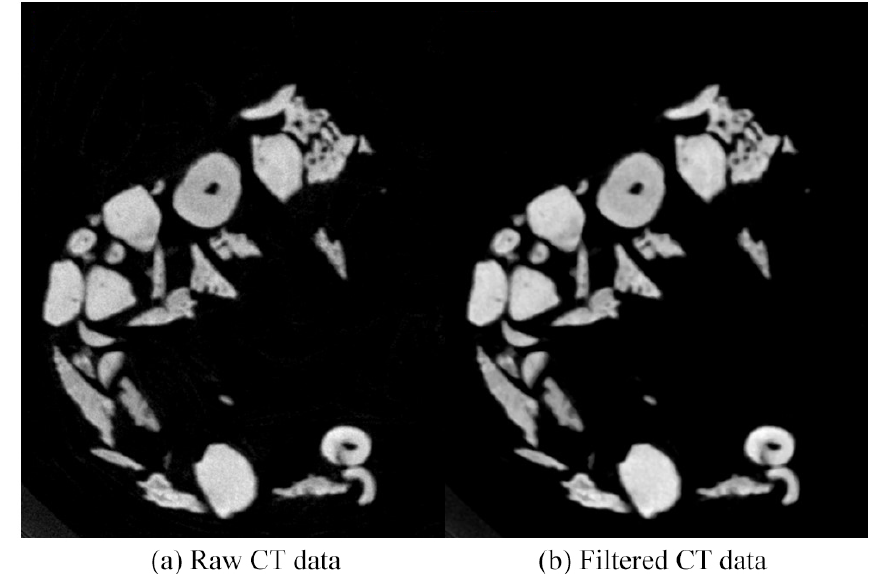
Figure 1. CT data before and after median filtering.